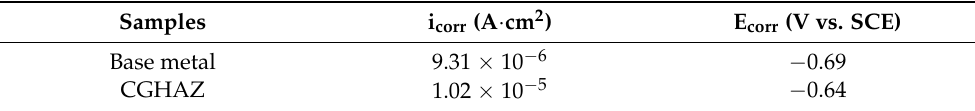
Figure 6. The impedance diagrams for the base metal and CGHAZ in 3.5 wt.% NaCl. ( a ) Nyquist plots, ( b , c ) Bode plots and ( d ) proposed equivalent circuit.